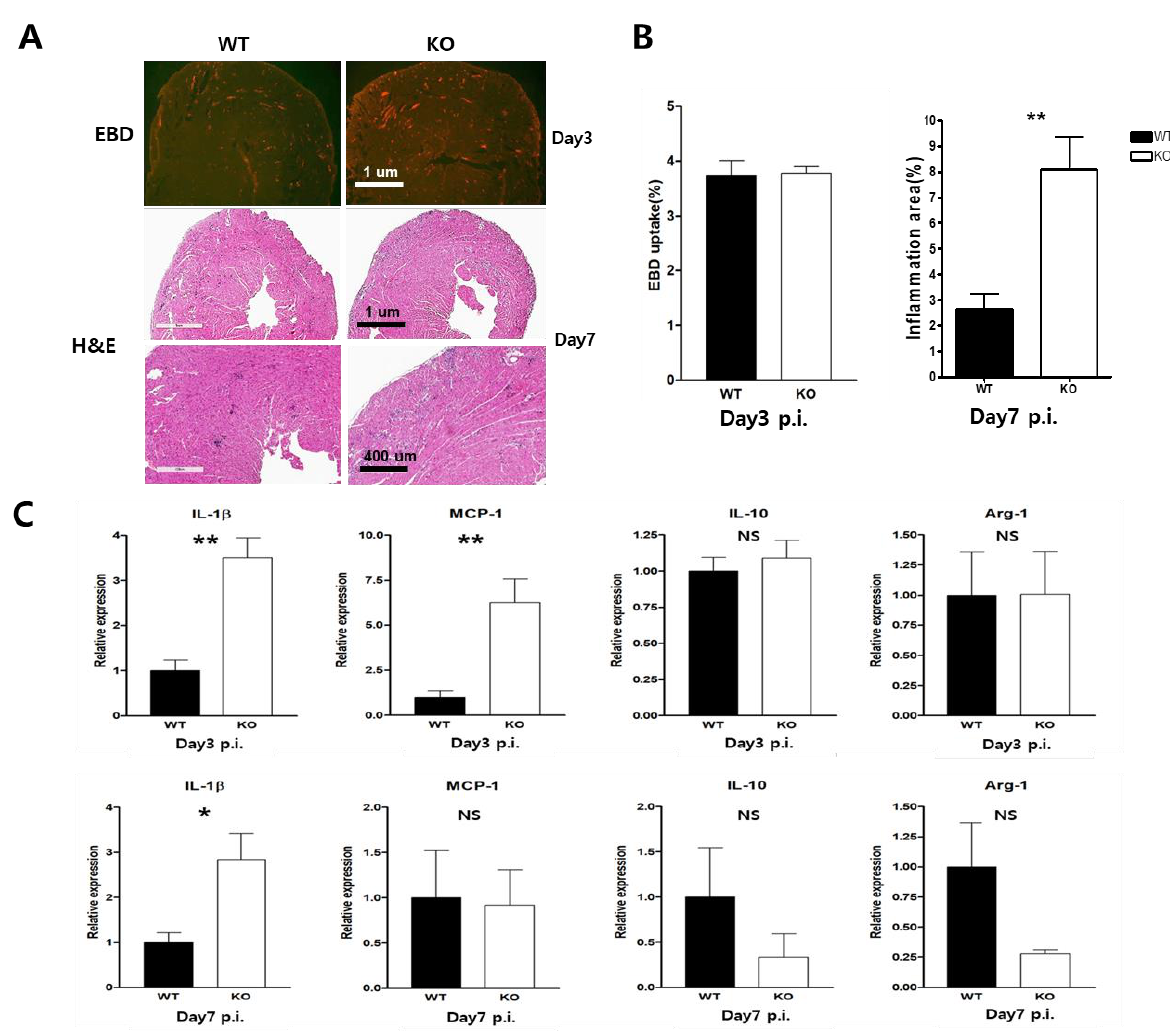
Figure 4. Heart inflammatory cell infiltration increased in CAR knockout mice. ( A ) WT and KO mice were injected with 10% Evans blue dye (EBD) for 18 h before being sacrificed. The heart was sectioned and subjected to fluorescence microscopy to determine the area of EBD uptake at day three p.i. The histological findings from the sectioned hearts showed inflammatory cell infiltration using Hematoxylin and Eosin (H&E) staining at day seven p.i. ( B ) Quantification of EBD uptake lesions and inflammation lesions (%) of the heart ( n = 3 for each group). ( C ) RNA extracted from the heart was subjected to real-time PCR using the indicated primers. All data are expressed as the mean ± SEM. NS, not significant, * p < 0.05 and ** p < 0.01 according to a two-tailed Student’s t -test.